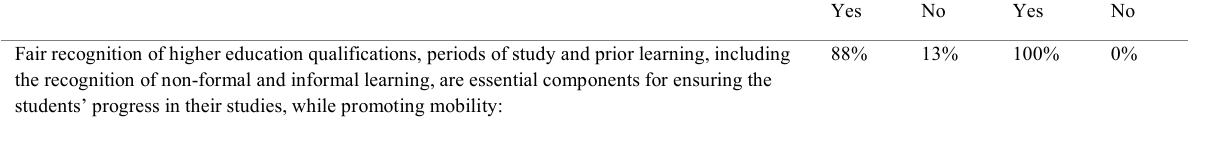
Kosovo Albania Yes No Yes